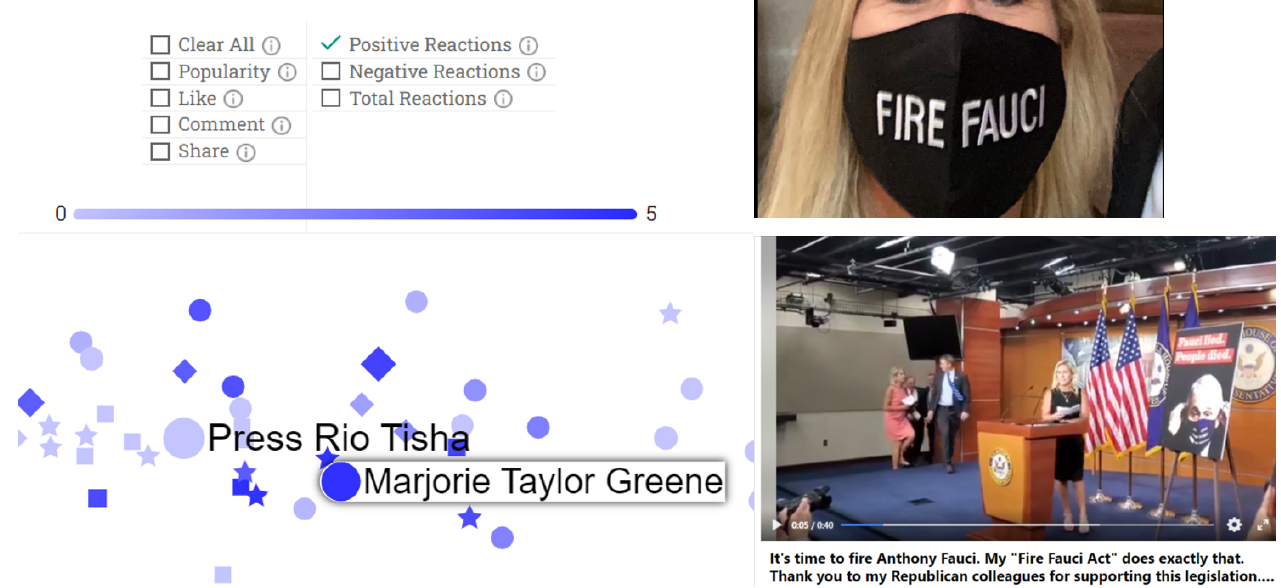
Figure 10. Inspecting the positive reactions filter feature and retrieving the popular account of Marjorie Taylor Greene, which aims to influence the public against